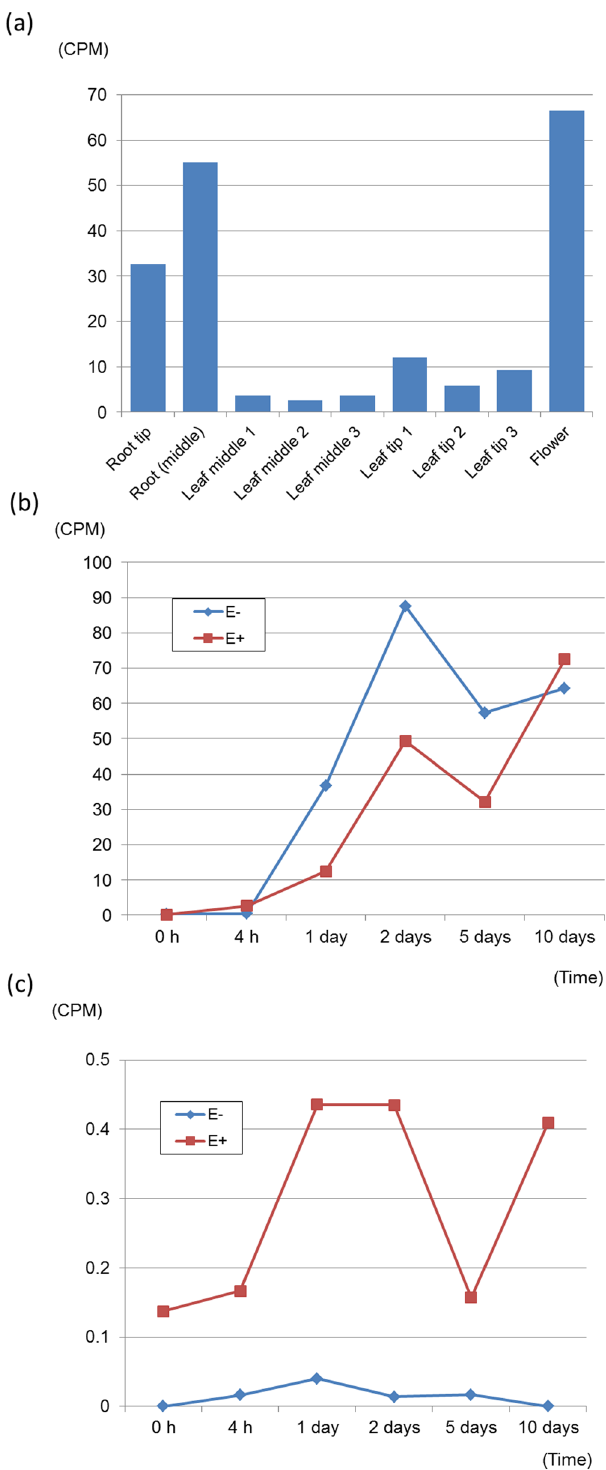
Figure 3. The expression levels of Lp BGNL and the E . festucae var. lolii ß-1,6-glucanase gene. ( a ) The expression level of Lp BGNL in each tissue of perennial ryegrass. The y-axis shows normalised read count number (CPM). ( b and c ) The expression levels of the genes in E − and E + perennial ryegrass genotypes. The x-axis shows time since the germination treatment, and y-axis shows CPM for Lp BGNL ( b ) and the E . festucae var. lolii ß-1,6- glucanase gene ( c